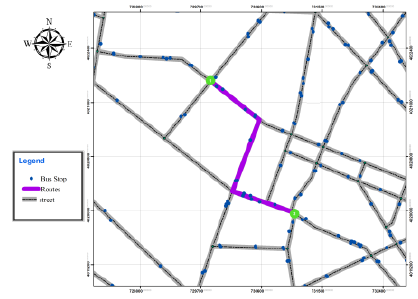
Figure. 10 The path proposed by the system to the